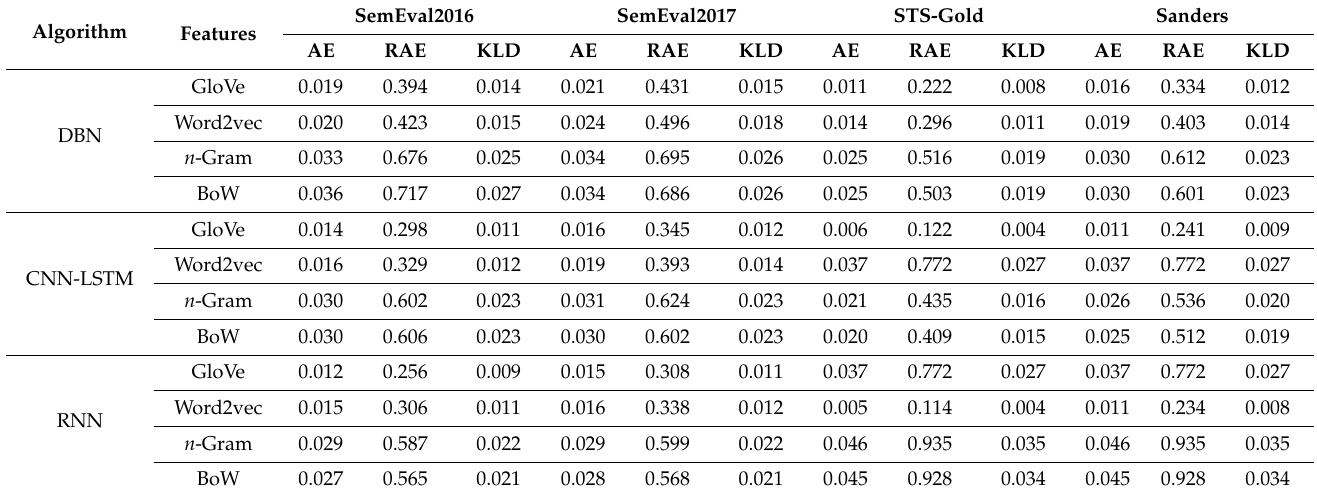
Table 10. Sentiment quantification based on deep